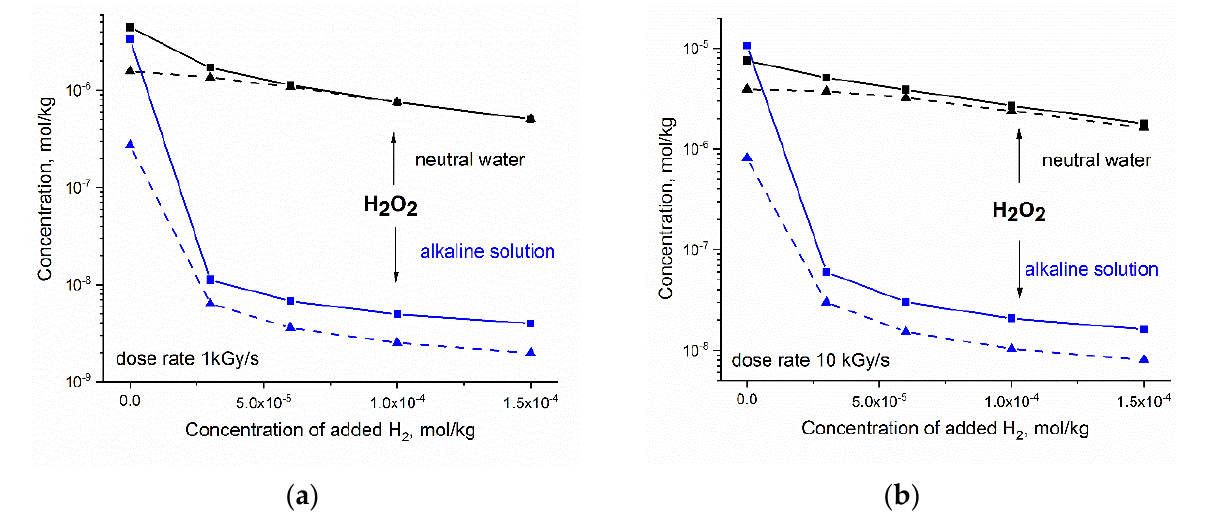
Figure 4. Simulated response of the steady state concentration of H 2 O 2 to hydrogen addition to neu- tral water at 300 °C (black) and to alkaline solution containing 2·10 − 4 mol ⋅ kg − 1 OH − ions (blue): ( a ) dose rate 1 kGy·s − 1 ; ( b ) dose rate 10 kGy·s − 1 . Solid and dashed lines refer to fast neutron and gamma radiolysis, respectively.